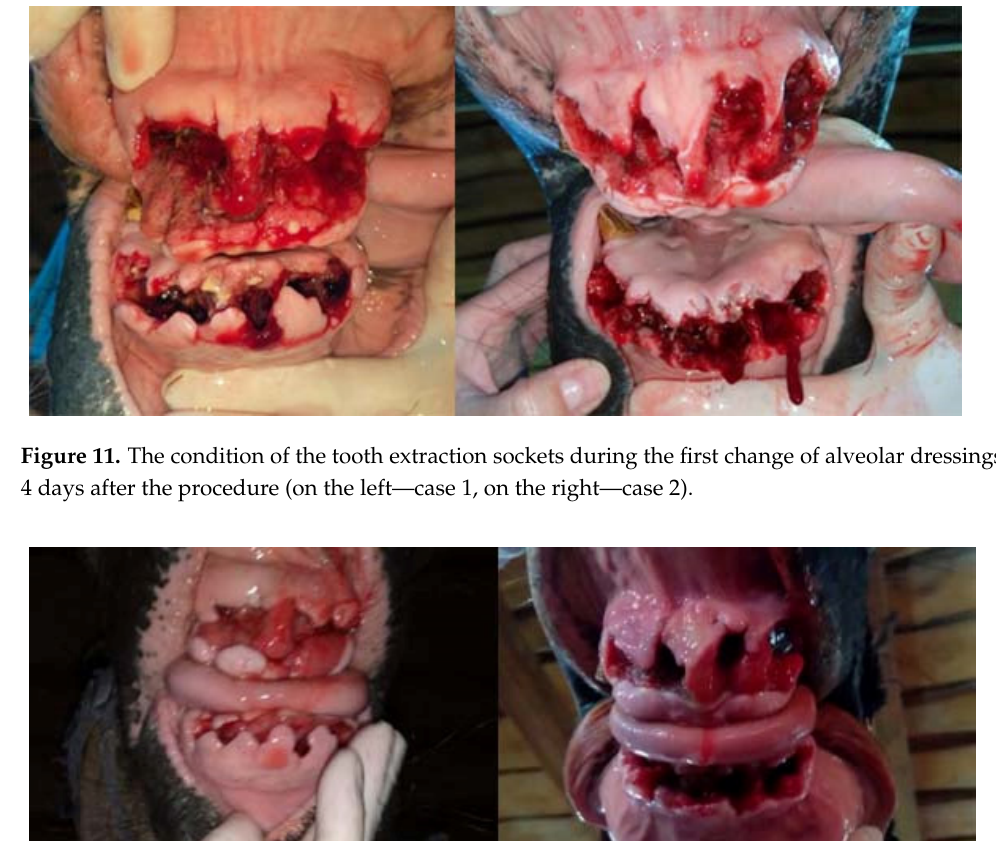
Figure 12. The condition of the tooth extraction sockets during the first change of alveolar dressings 9 days after the procedure (on the left—case 1, on the right—case 2). The horse undergoing hyper ‐ baric oxygen therapy (case 1) had less swelling, faster gingival shrinkage and faster filling of the alveoli with granulation tissue.